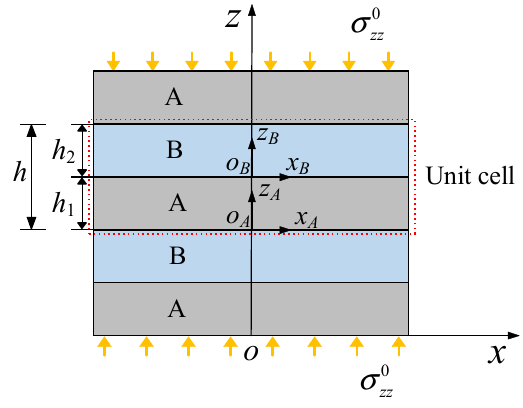
Figure 1. Traditional layered periodic foundation with identical unit cells.